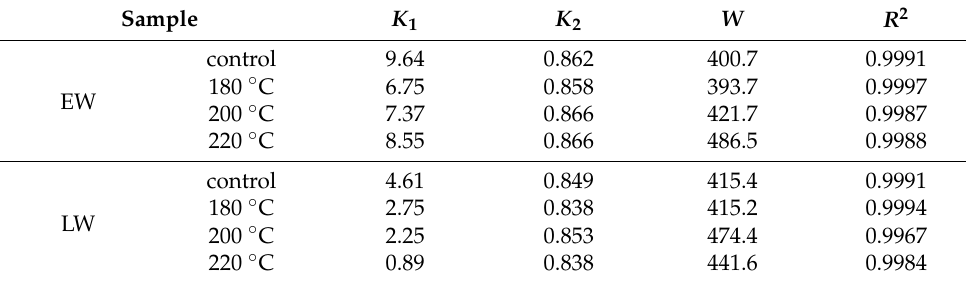
Table 1. Hailwood-Horrobin fitting